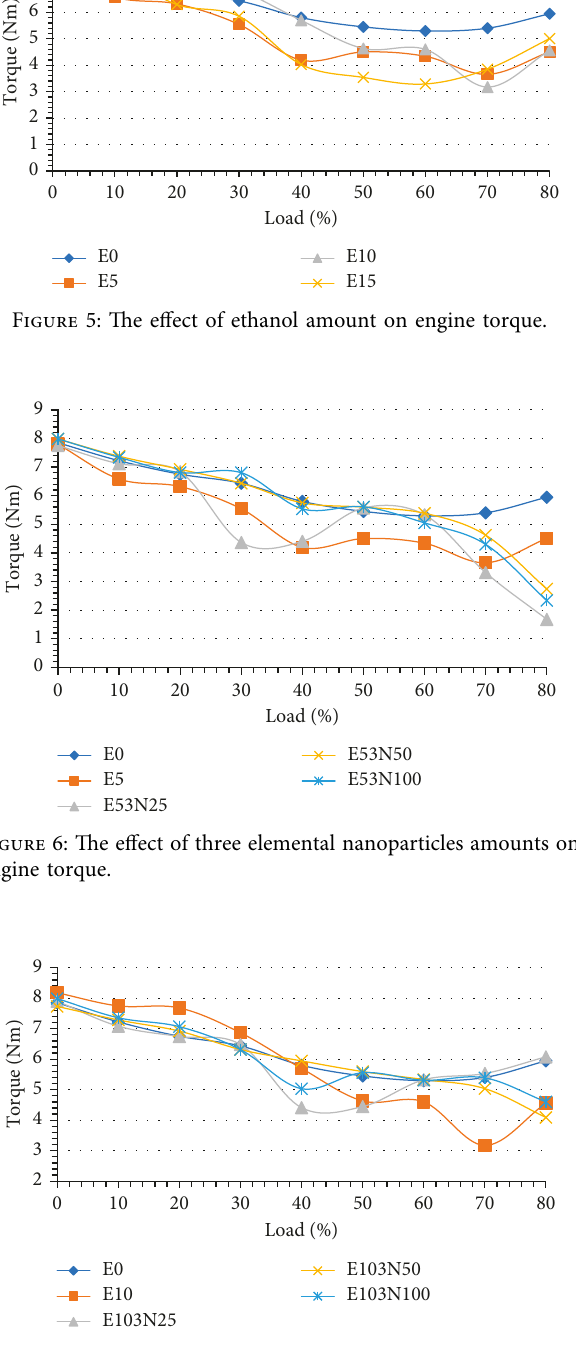
Figure 7: The effect of 3 elemental nanoparticles addition on the engine torque output of E10 fuel sample.